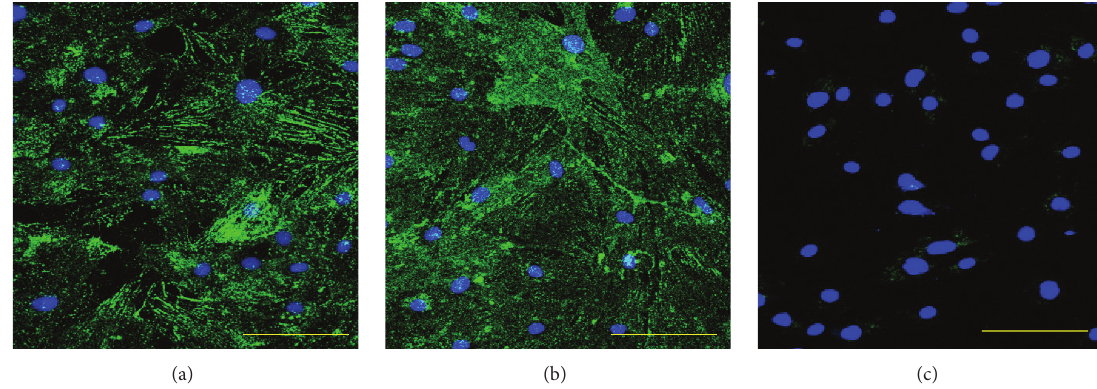
Figure 22: Immunofluorescence staining of CD44. Immunofluorescence staining of CD44 of the cell lines of OSA-CSCs, OSA3-CSCs (a) and OSA3-CSCs II (b). (c) Negative control. LSCM in conventional colors: green for CD44 and blue for nuclei. Original magnifications: 20x. Bar size: 100 𝜇 m.